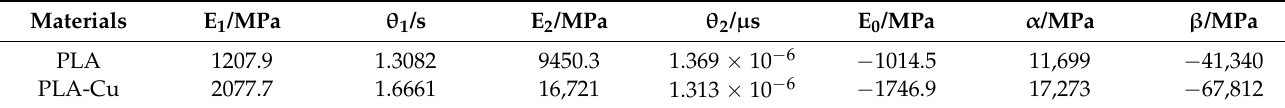
Figure 13. Comparison of PLA ‐ Cu experimental curve and fitting curve. ( a ) Low strain rate stress difference; ( b ) low strain rate; ( c ) high strain rate. Table 11. Parameters of ZWT constitutive equation.